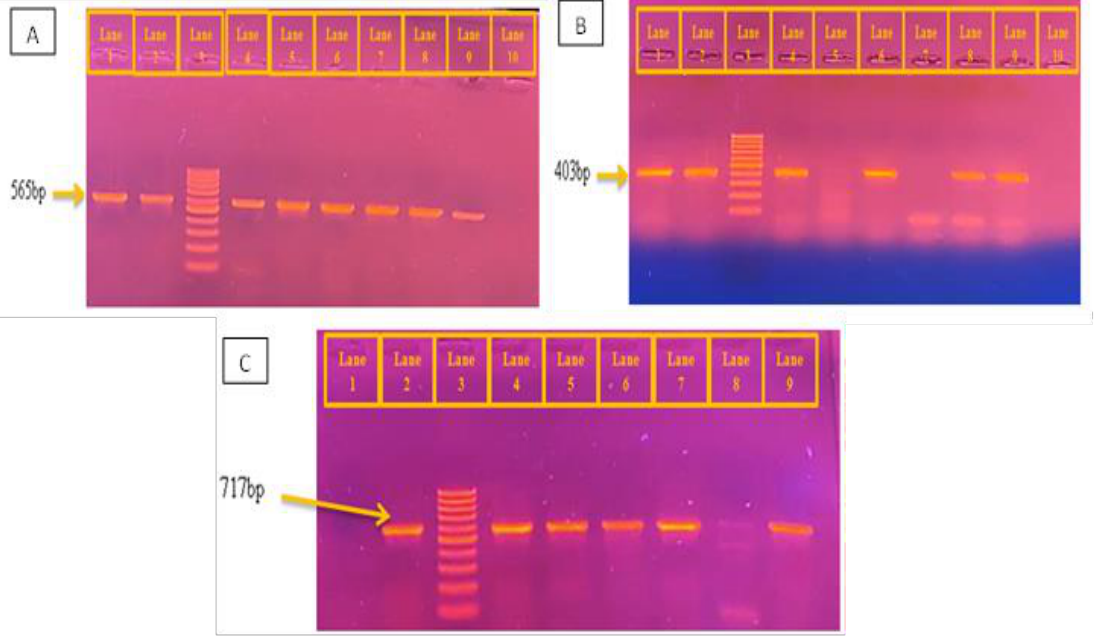
Figure 2. Ethidium bromide-stained agarose gel electrophoresis for detection of integron amplicon products. A) class 1 integron amplicon products (565 bp) represented by lanes 1, 2, 4, 5, 6, 7, 8 and 9. Lane 3 represents the DNA ladder (100 bp), while lane 10 represents the negative control. B) class 2 integron amplicon products (403 bp) represented by lanes 1, 2, 4, 6, 8 and 9. Lane 3 represents the DNA ladder (100 bp), while lane 10 represents the negative control. C) class 3 integron amplicon products (717 bp) represented by lanes 2, 4, 5, 6, 7 and 9. Lane 3 represents the DNA ladder (100 bp), while lane 1 represents the negative